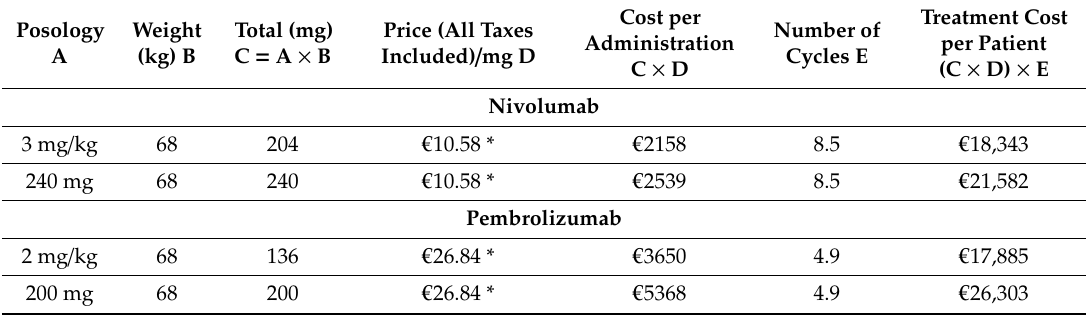
Table 4. Annual cost calculation of treatment with nivolumab and pembrolizumab for patients treated in the 2nd